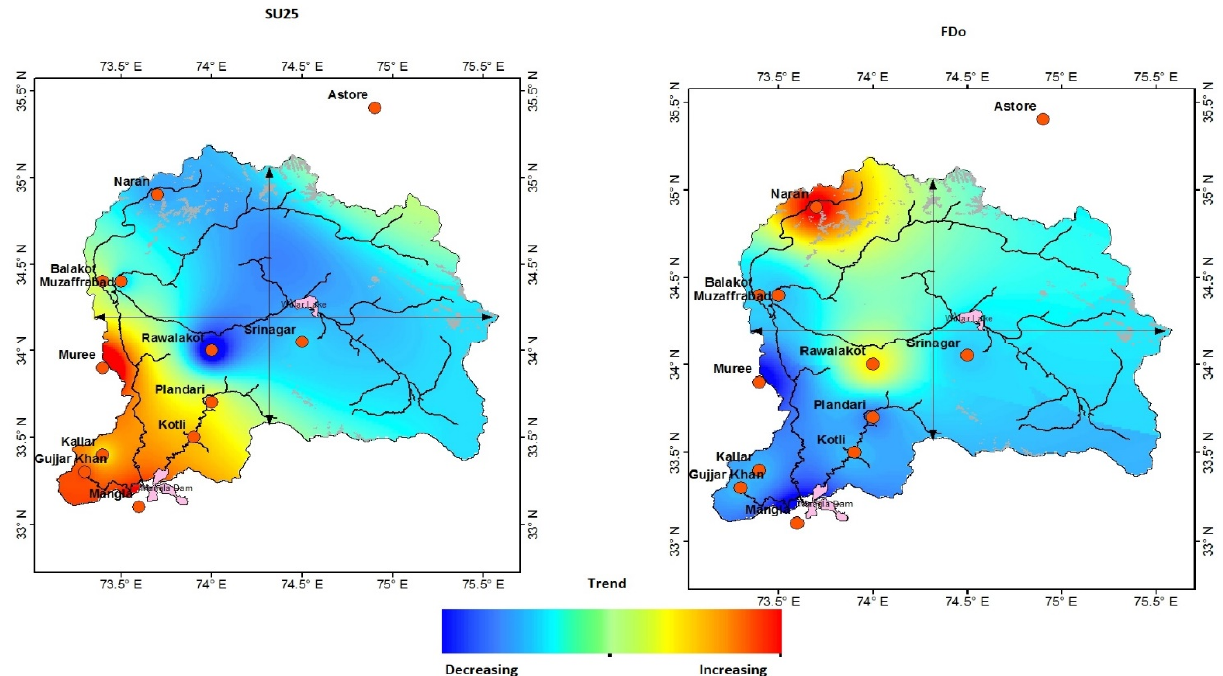
Figure 3. Absolute temperature indices summer days (SU 25 ) and frost days (FDo).